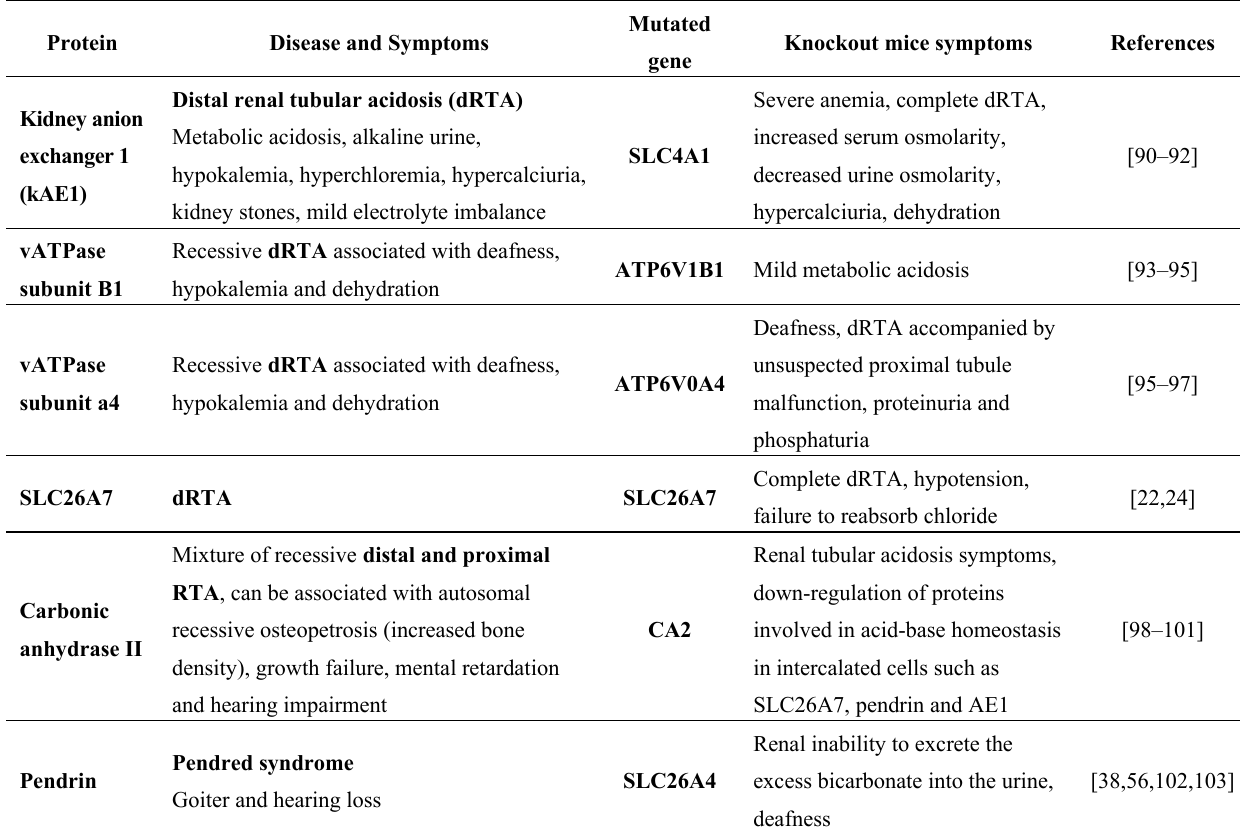
Table 2. Diseases associated with abnormal intercalated cell